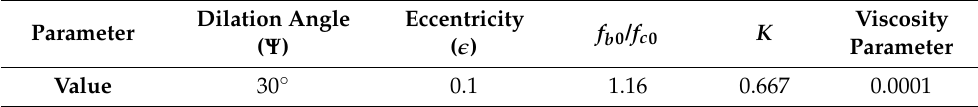
Table 1. Values of plastic damage parameters used for concrete